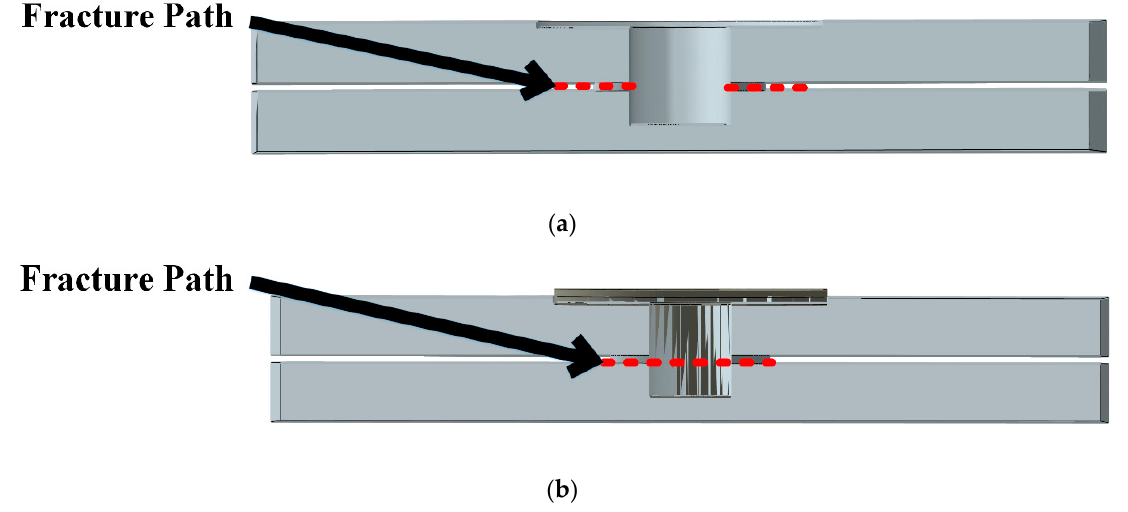
Figure 5. The fracture path for FSSW joint ( a ) with probe hole and ( b ) with refilled probe hole.